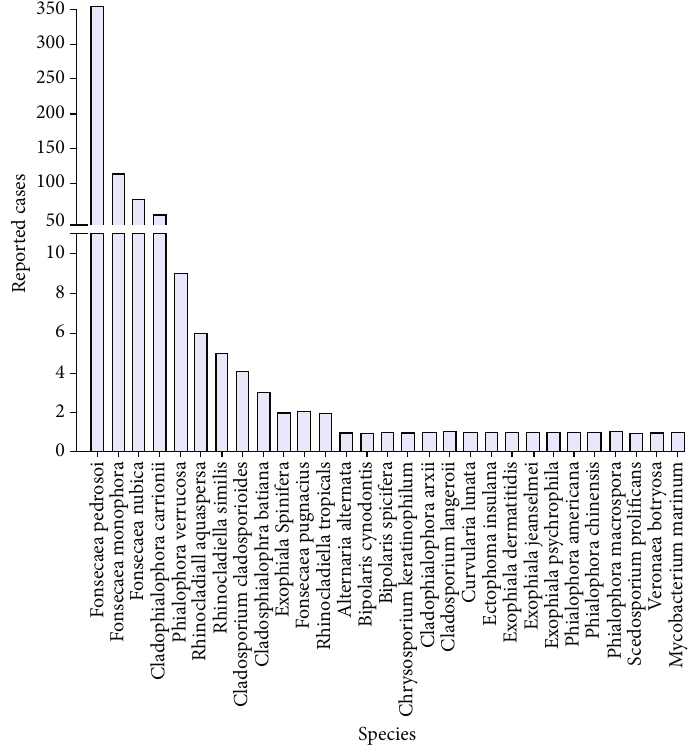
Figure 2: Distribution of human cases of CBM by etiologic agents. In the last 10 years, most published works identi fi ed the genus Fonsecaea and the following species F . pedrosoi , F . monophora , and F . nubica as the main etiologic agents of CBM. The Cladophialophora genus ( C. carrionii ) is the second most common a ff ecting